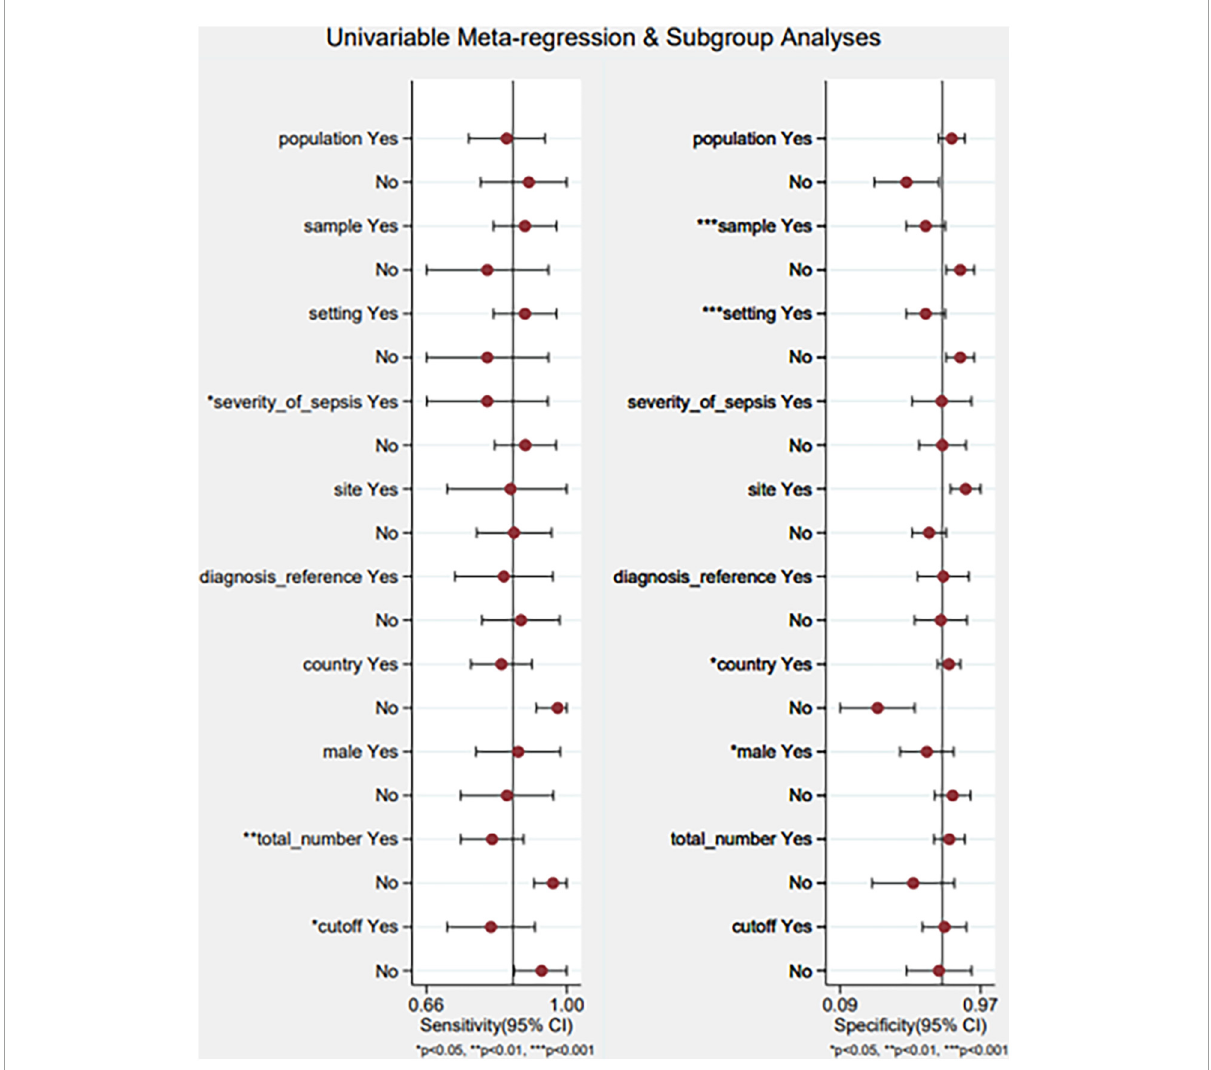
FIGURE9 Meta-regression using a single variable and subgroup analysis. Yes/no represents that: population (adults/neonates), sample (serum/plasm), setting (ICU/other), severity of sepsis (severe sepsis or septic shock/other), site (celiac infection/other), diagnostic reference (sepsis-3/other), country (China and Iran), male (%) ( ≥ 55/ < 55), total number of samples ( ≥ 100/ < 100), cutoff ( ≥ 50/ < 50